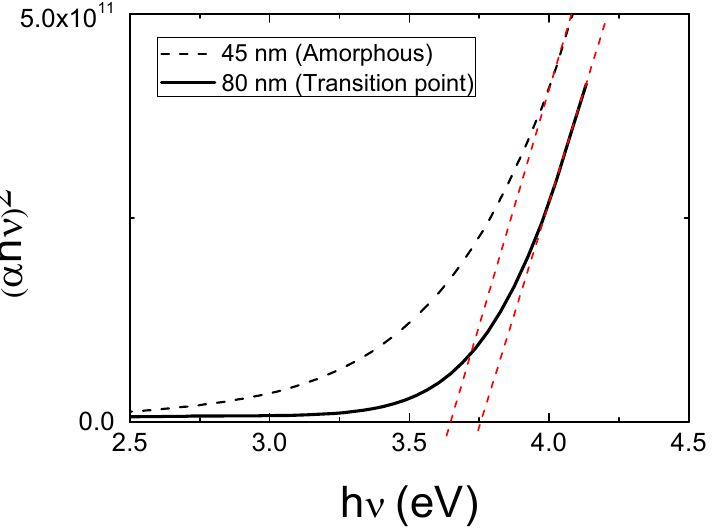
Figure 2. ( α h ν ) 2 versus photon energy (h ν ) used to calculate the band gap energy values of the thin films at the transition from amorphous to pc nature.